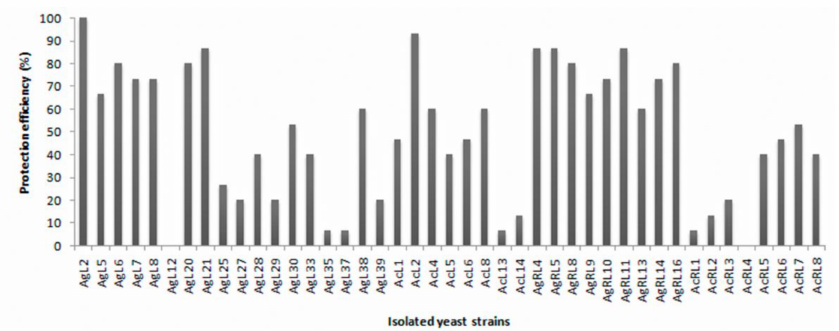
Figure 3. Wound protection efficiency of yeasts in the in vivo microscale assay. The 43 yeasts that most inhibited the mycelial growth of P. digitatum in the in vitro test were evaluated in a microscale assay against the pathogen after 5 days of incubation at 25 ◦ C.